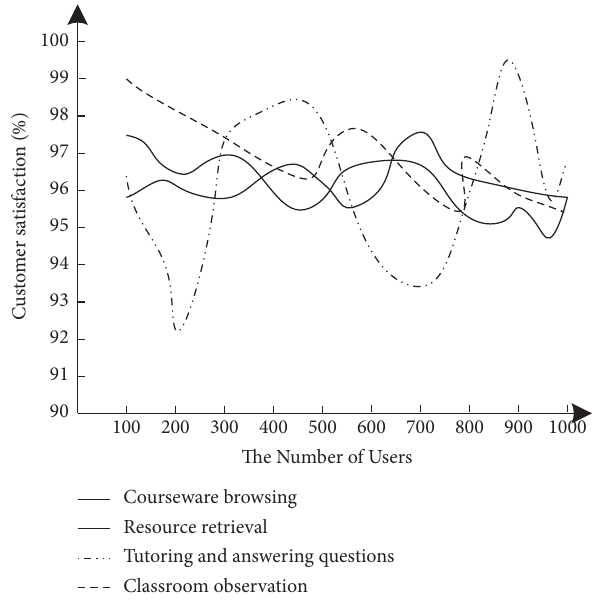
Figure 9: Customer satisfaction survey.